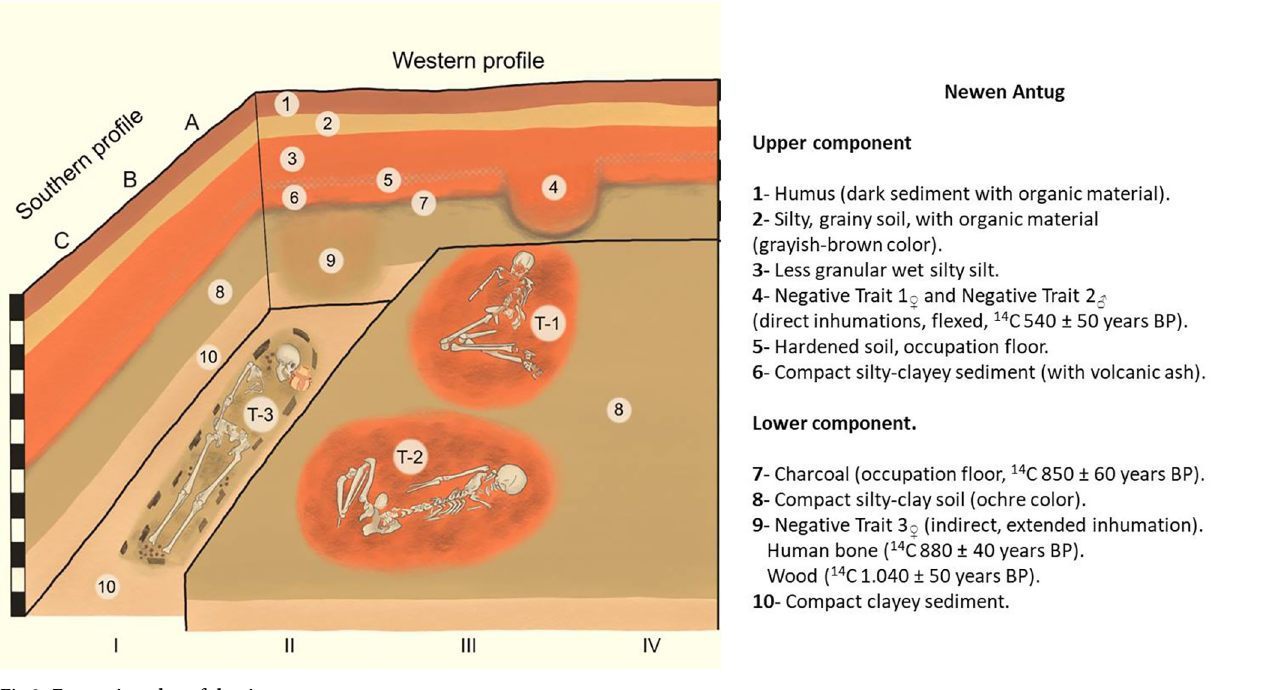
Fig 3. Excavation plan of the